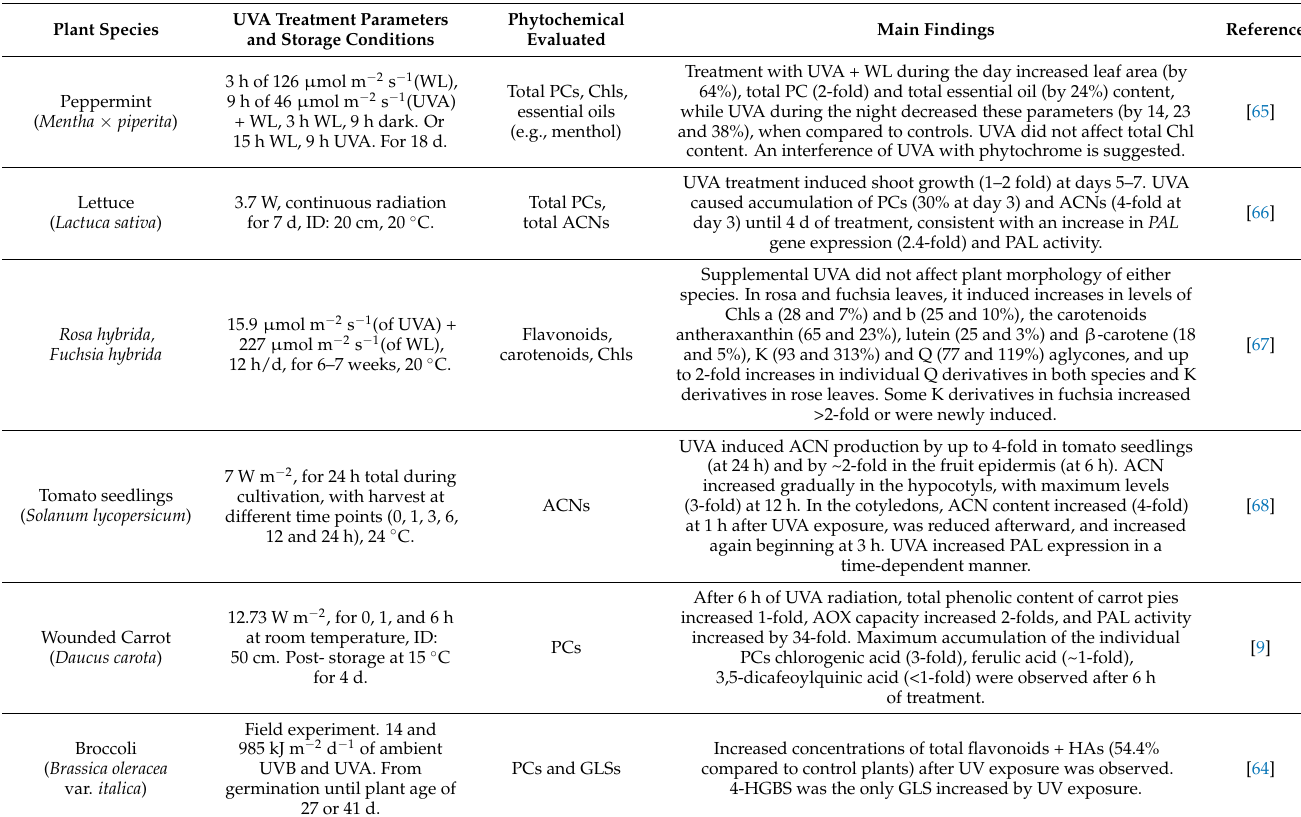
Table 2. Effect of UVA (alone or in combination with UVB) radiation on the biosynthesis of bioactive phytochemicals and on stress responses in different horticultural